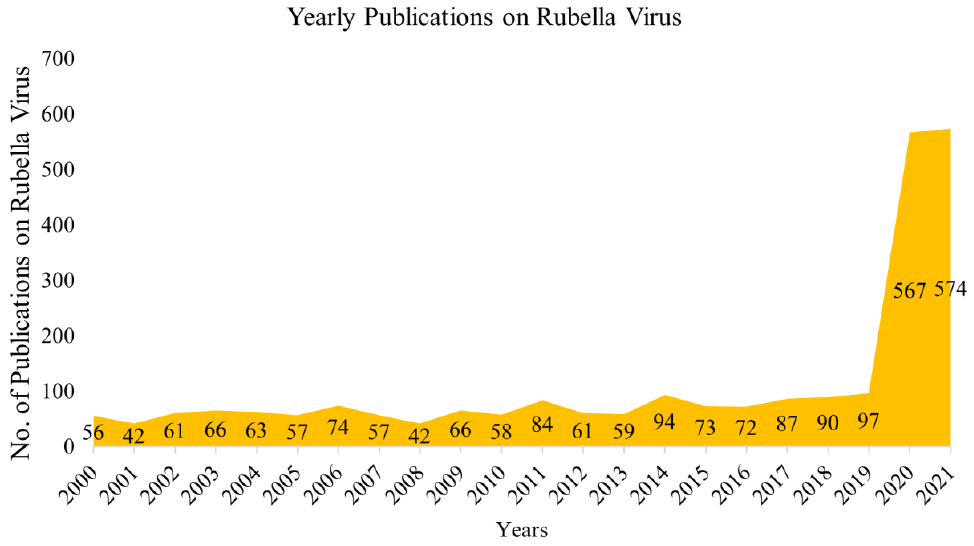
Figure 2. The trend in annual scientific publications on rubella virus.